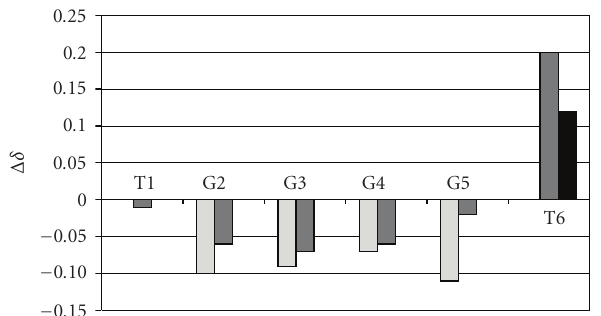
Figure 6: Di ff erence in chemical shifts ( Δ δ ) of DNA upon binding of 1 (complex 1 : DNA minus DNA alone) with [d(TGGGGT)] 4 . Δ δ values are reported for imino (light gray), aromatic (dark gray), and methyl (black)